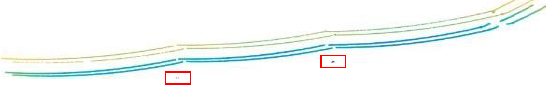
Figure 11. Power line points extraction results when v f = 4